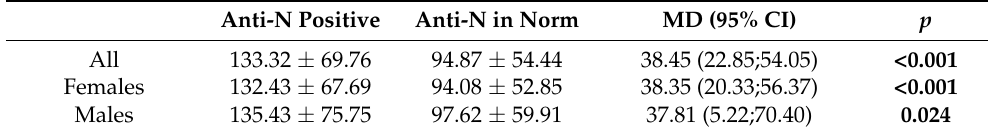
Table 8. Comparison of anti-S antibody levels between anti-N